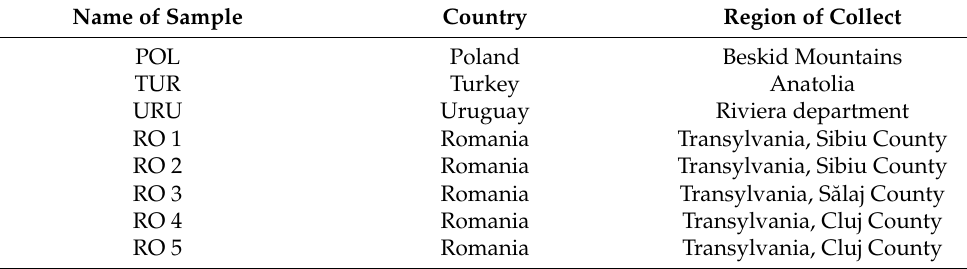
Table 3. Names and origin of propolis